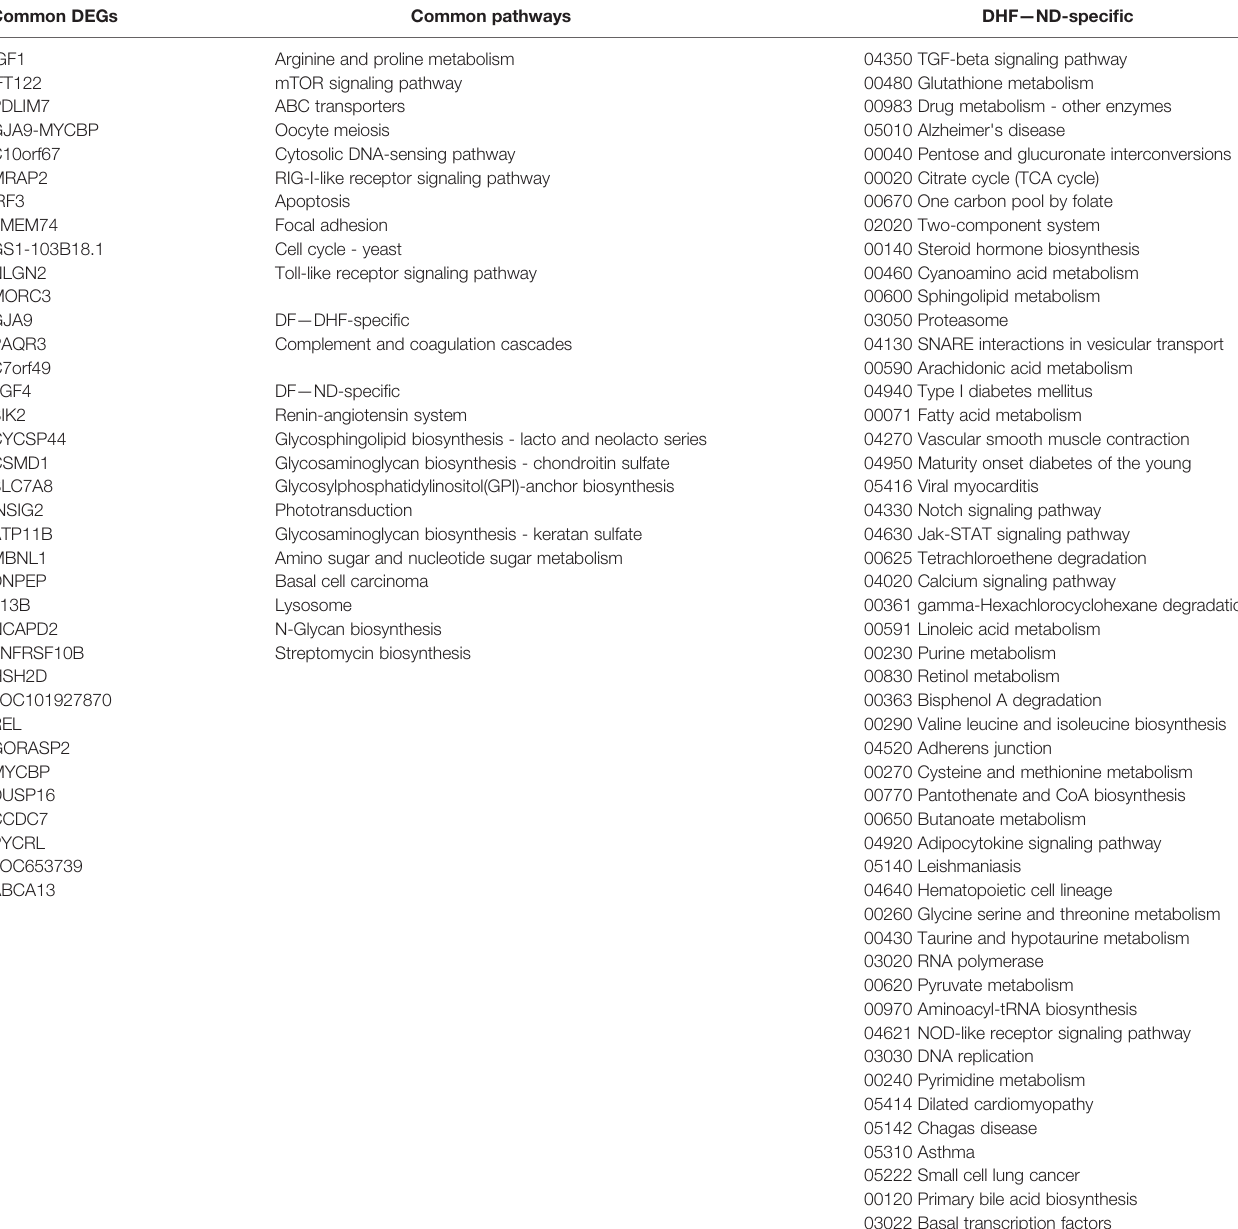
TABLE 1 | Condition-speci fi c pathways: (A) Common DEGs & pathways between DH vs DHF and DHF vs ND (B) DF — DHF-speci fi c (1 pathway), and (C) DF — ND- speci fi c (11 pathways), and (C) DHF — ND-speci fi c (50 pathways). Common